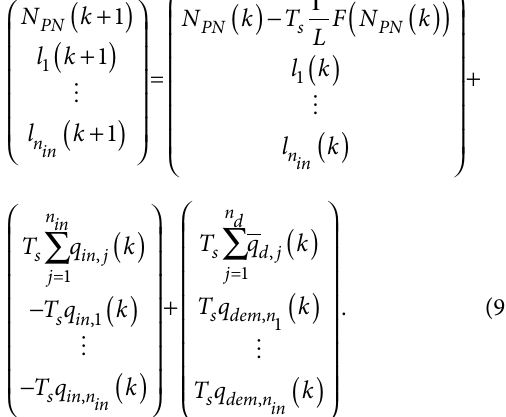
Exit of network Uncontrolled gateControlled